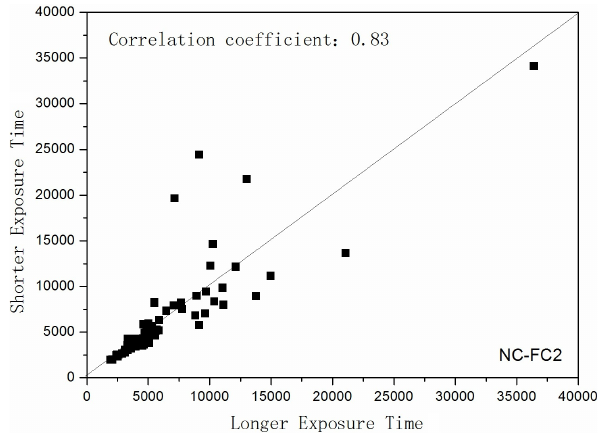
Fig. 6. Digital images of the same target in the same location with different zoom settings. Figure 6. Digital images of the same target in the same location with different zoom 493 settings. 494